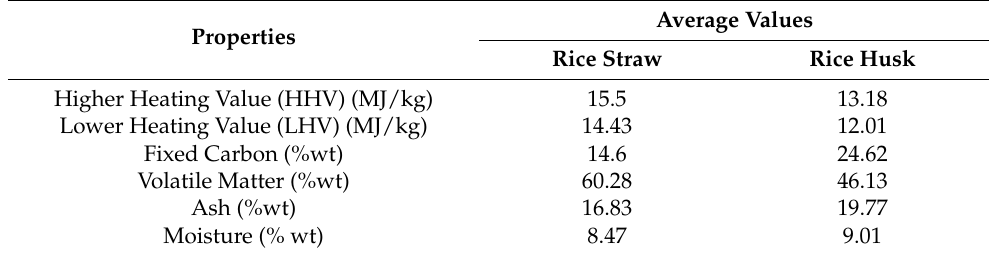
Table 3. Proximate analysis of dry-basis samples of rice straw and rice husk, data obtained from